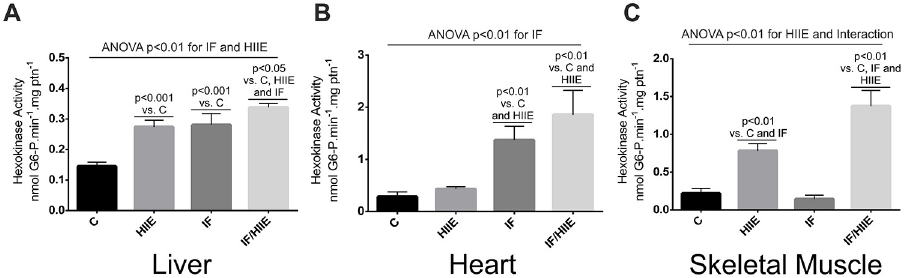
Fig 4. Synergistic effect of IF/HIIE on low Km HK activity. The enzymatic activity was calculated from the NADPH production. (A) HK activity in the liver. (B) HK activity in the heart. (C) HK activity in the skeletal muscle (gastrocnemius). Each bar represents the mean ± SD; A-C) n = 6. Individual effects (IF and HIIE) and the effect of their interaction were verified by two-way ANOVA and multiple comparisons; p values were annotated.